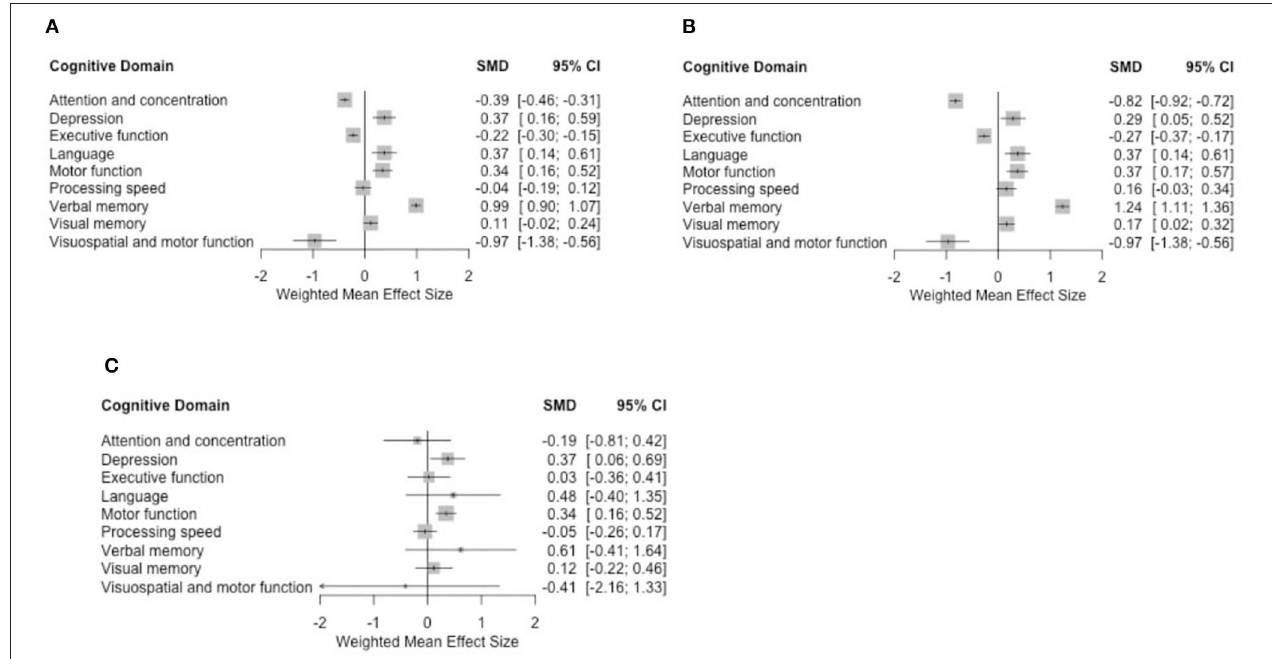
FIGURE 3 | Forest plots using (A) fixed-effect model for all studies, (B) fixed-effect model for cohort studies only, and (C) random-effect model for 6-month time-point